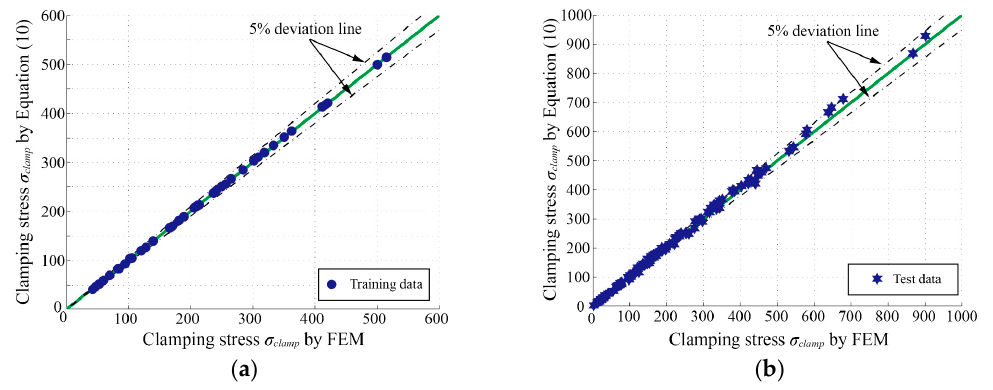
Figure 14. Comparisons of the clamping stresses ( σ clamp ) determined by FEM and Equation (10): ( a ) training data system; ( b ) test data system.